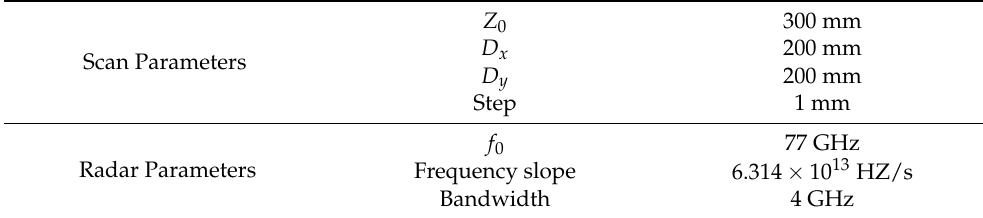
Table 1. Simulation parameters of near field synthetic aperture radar